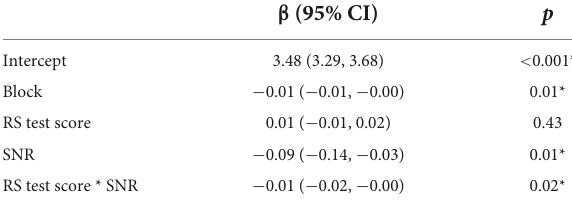
TABLE 1 Output summary of the linear mixed effects model with baseline pupil dilation as the outcome variable.